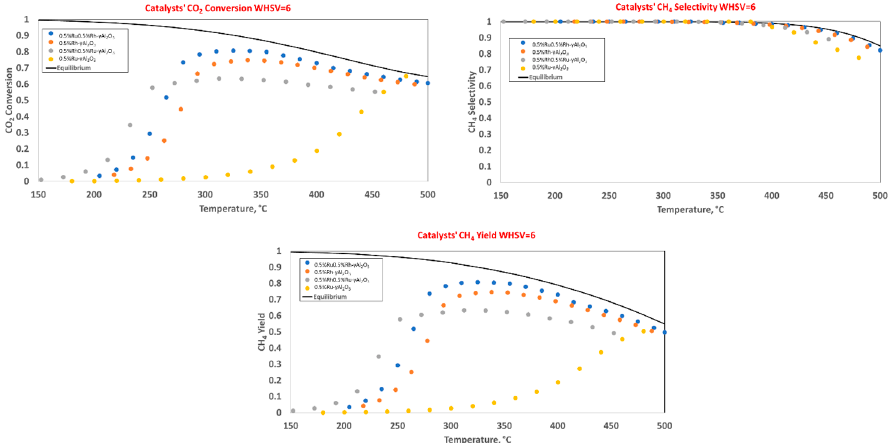
Figure 8. Catalysts’ CO 2 conversion, CH 4 selectivity and yield at WHSV = 6 NL/g cat h.